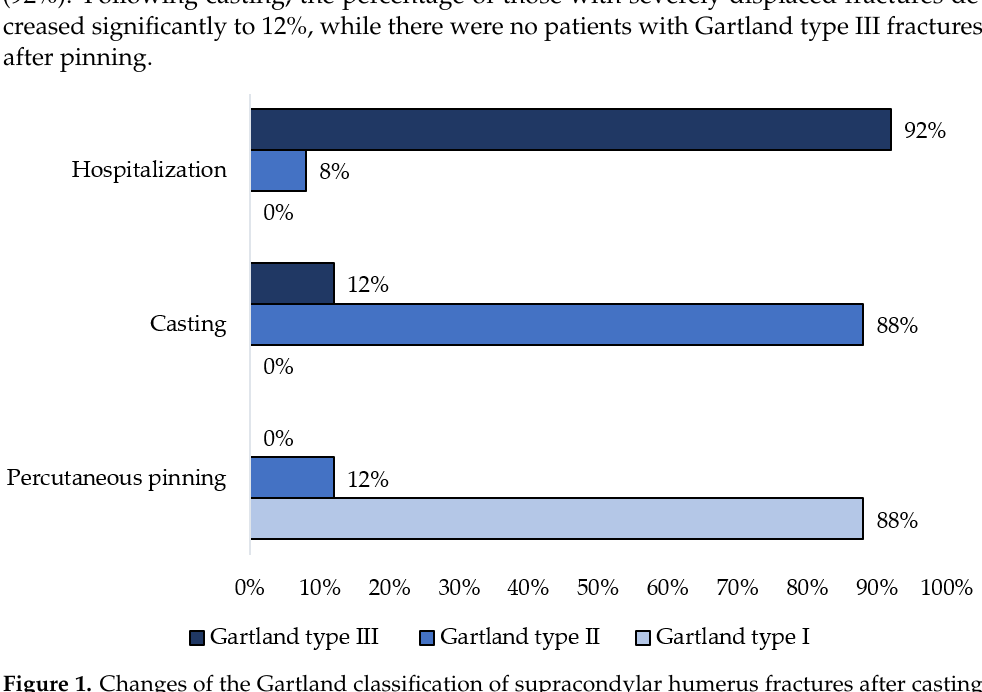
Figure 1. Changes of the Gartland classification of supracondylar humerus fractures after casting and after pinning. Doppler sonography failed to assess vascular lesions at the fracture site before and after casting in most patients (Table 2). Table 2. Brachial artery injuries and flow velocity around the fracture site with Doppler sonography classification, before and after casting.